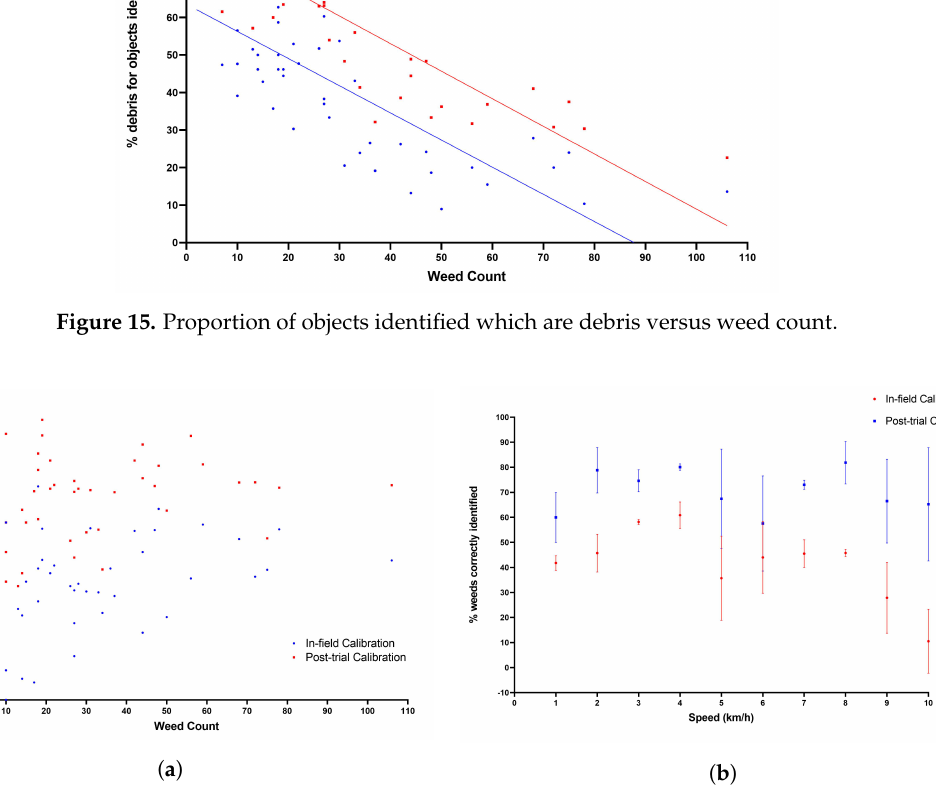
Figure 16. System weed identification capability with varying speed and weed count. ( a ) Percentage of correctly identified weeds versus total weed count. ( b ) Percentage of correctly identified weeds versus system speed